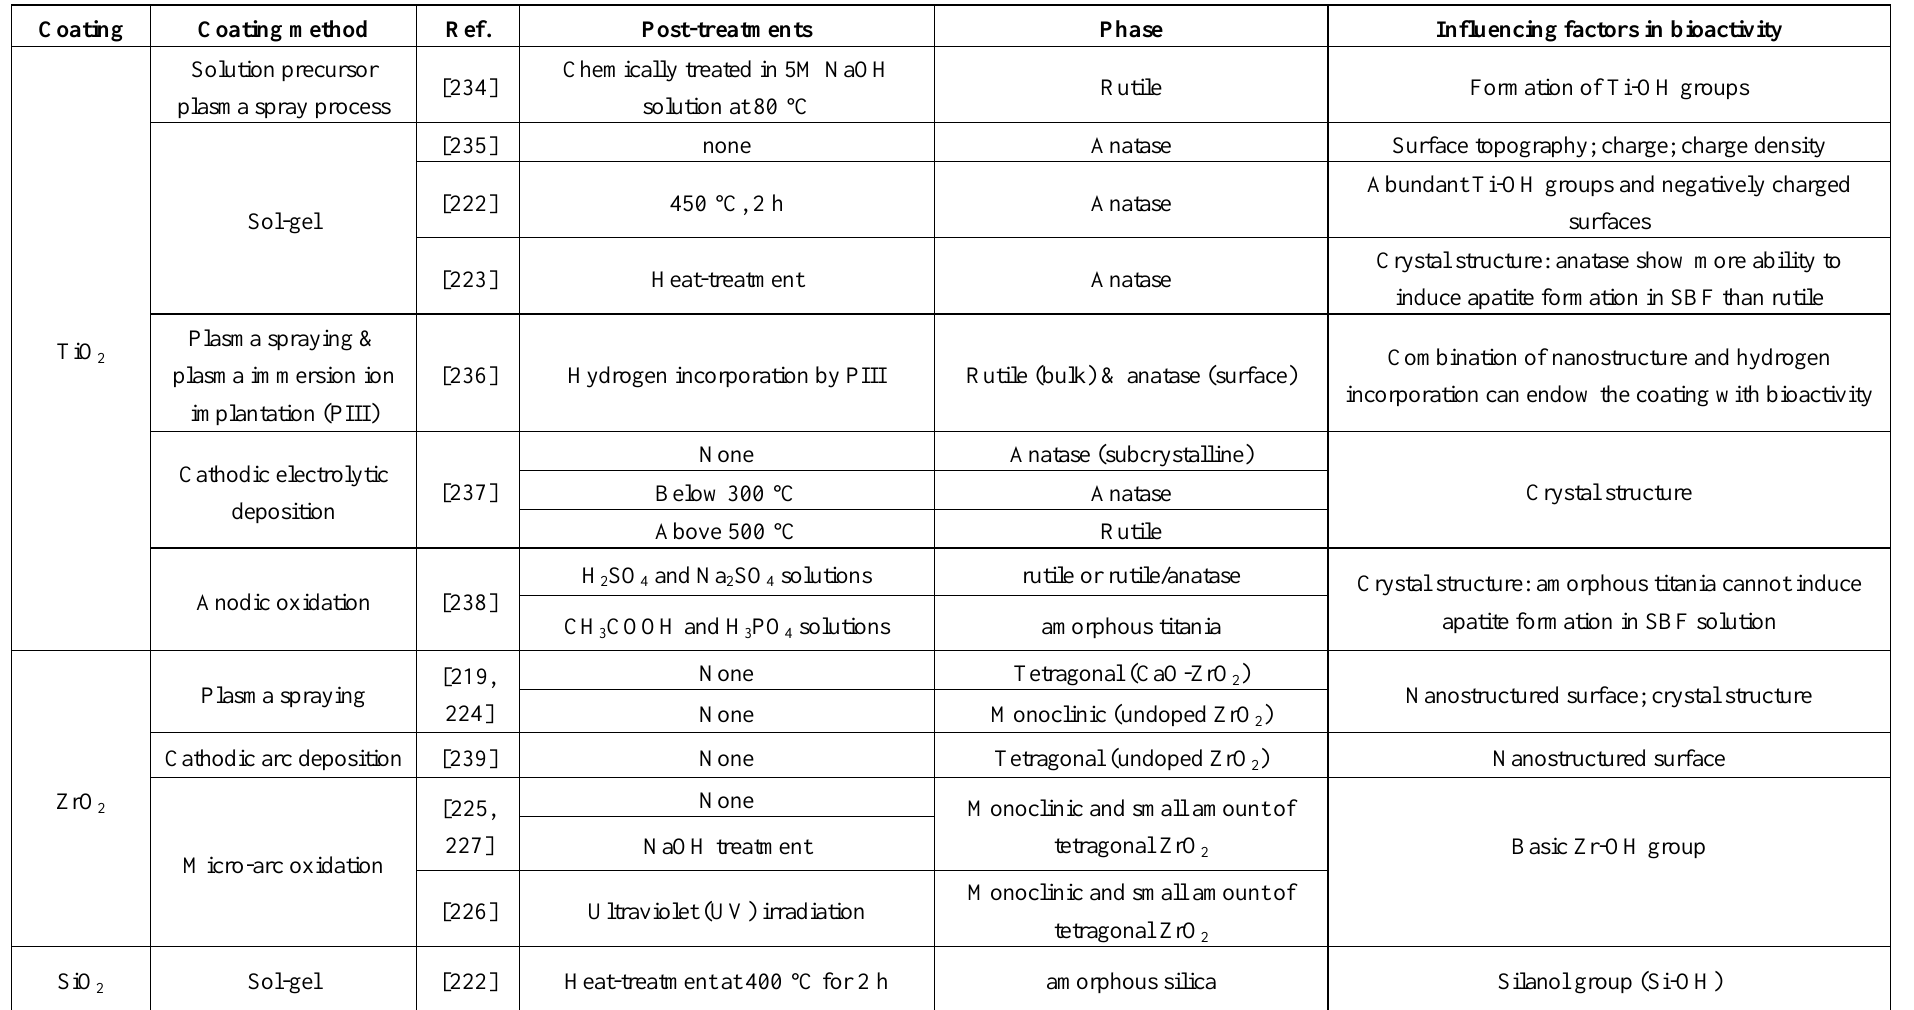
Table 5. Summary of bioactive oxide